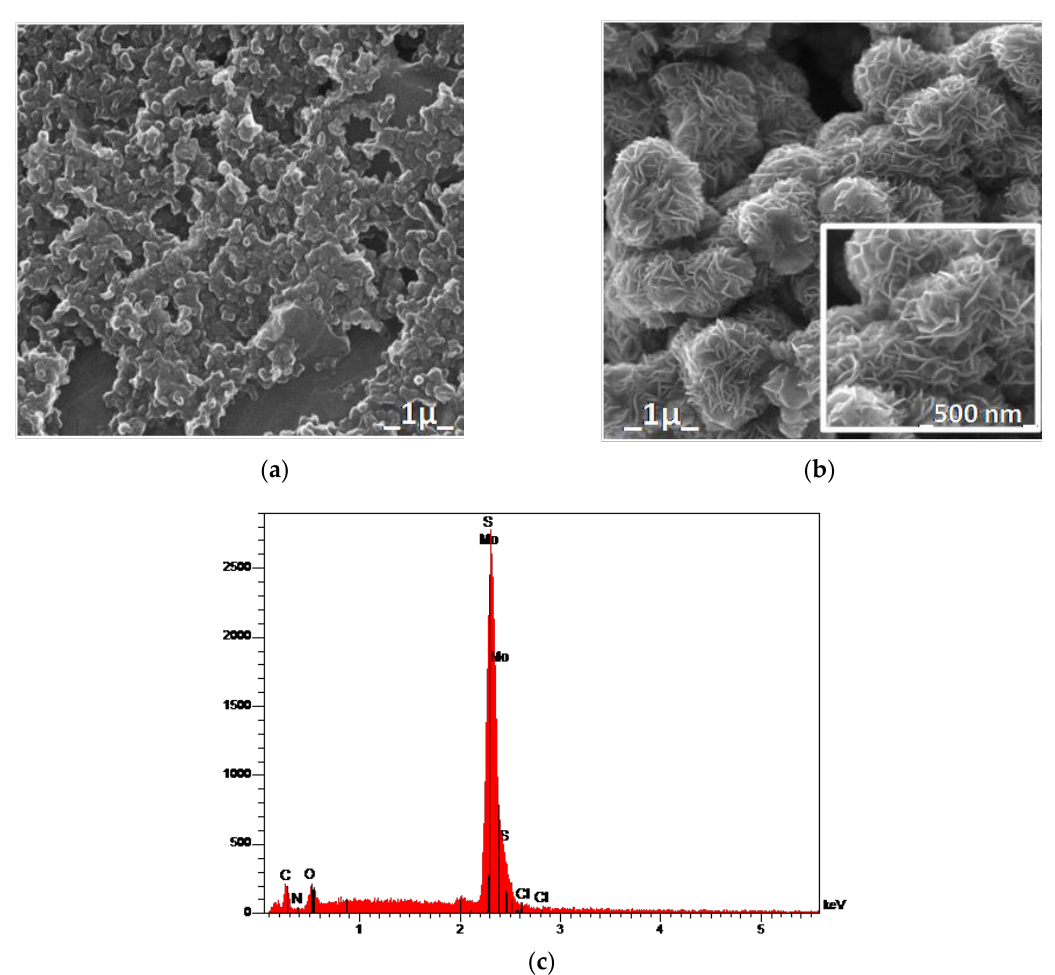
Figure 2. SEM images of: ( a ) bare screen-printed carbon electrode surface (SPCE); ( b ) SPCE modified LA–MoS 2 Nano-sheets; ( c ) EDX analysis of the modified SPCE with MoS 2 nano-sheets.